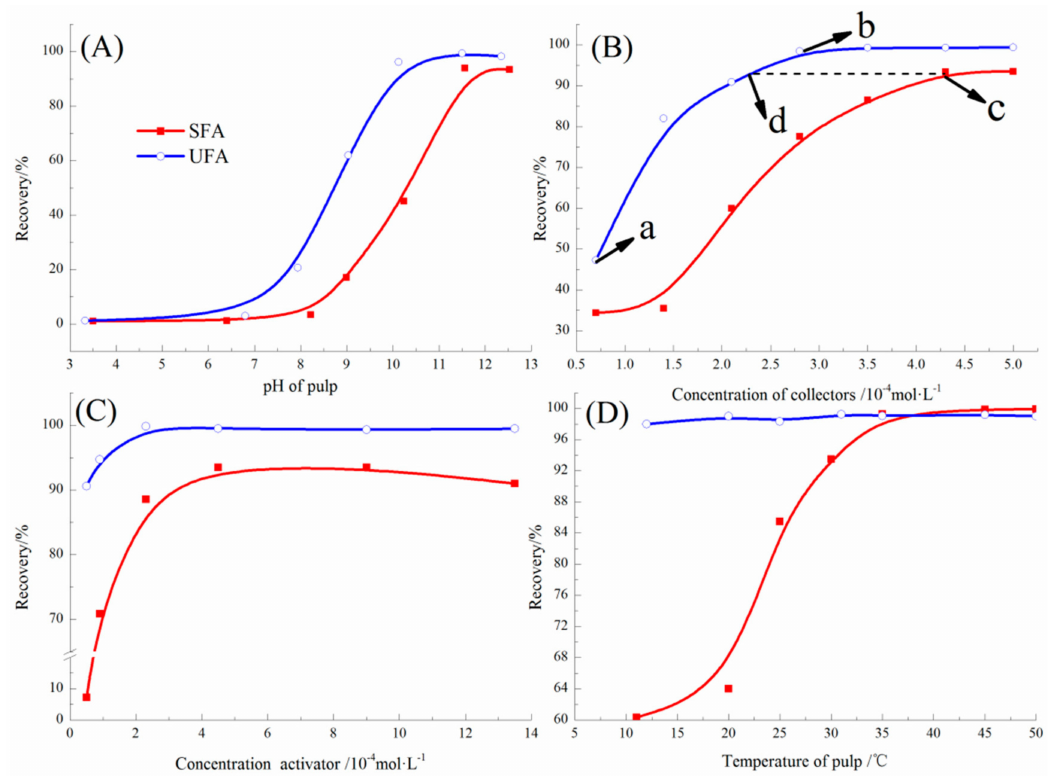
Figure 8. Recovery of quartz as a function of pulp pH ( A ), collector concentration ( B ), activator CaCl 2 concentration ( C ) and pulp temperature ( D ) with UFA or